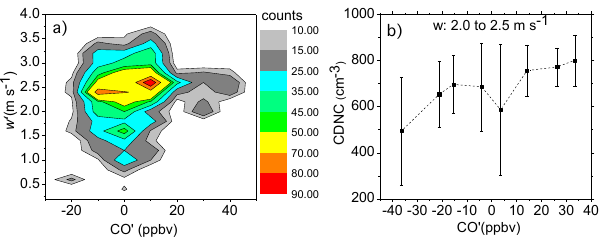
Figure 10. PDF of simulated cloud updraft speed and CO loading in cloudy updrafts (a) , and change in CDNC with perturbation values of CO (CO’) for perturbation values of w ( w ’) between 2.0 and 2.5ms − 1 (b) . Error bars in (b) indicate the standard